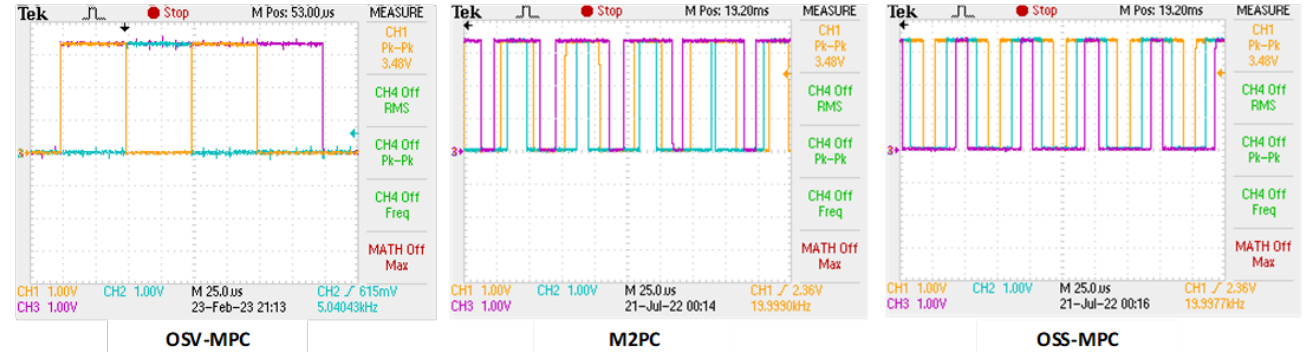
Figure 17. Comparison of phase a duty ratio for M2PC and OSS-MPC for P ∗ = 4 kW, Q ∗ = 4 kVAr (obtained from CCS).